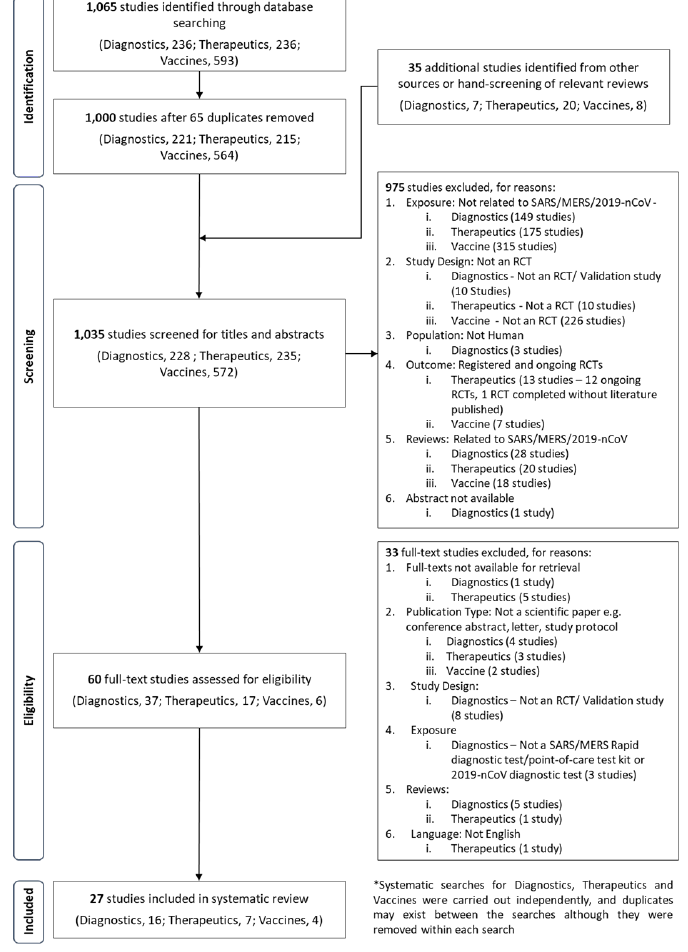
Figure 1. A PRISMA flow diagram of the search strategy for diagnostics, vaccine and therapeutics of 2019-nCoV, MERS-CoV and SARS-CoV.